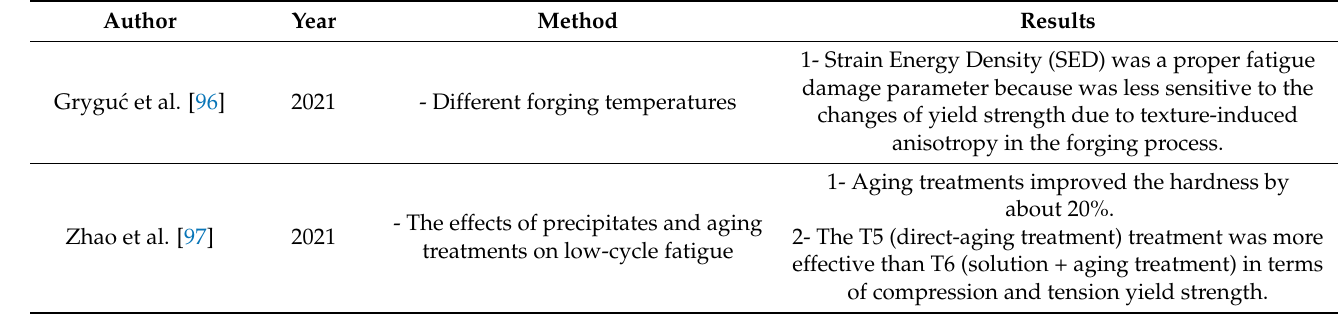
Figure 12. Schematic of the corrosion pit formation and crack growth of AZ80-T5 under 5% NaCl Table 9. The summary of novel research on the AZ80 magnesium alloys.